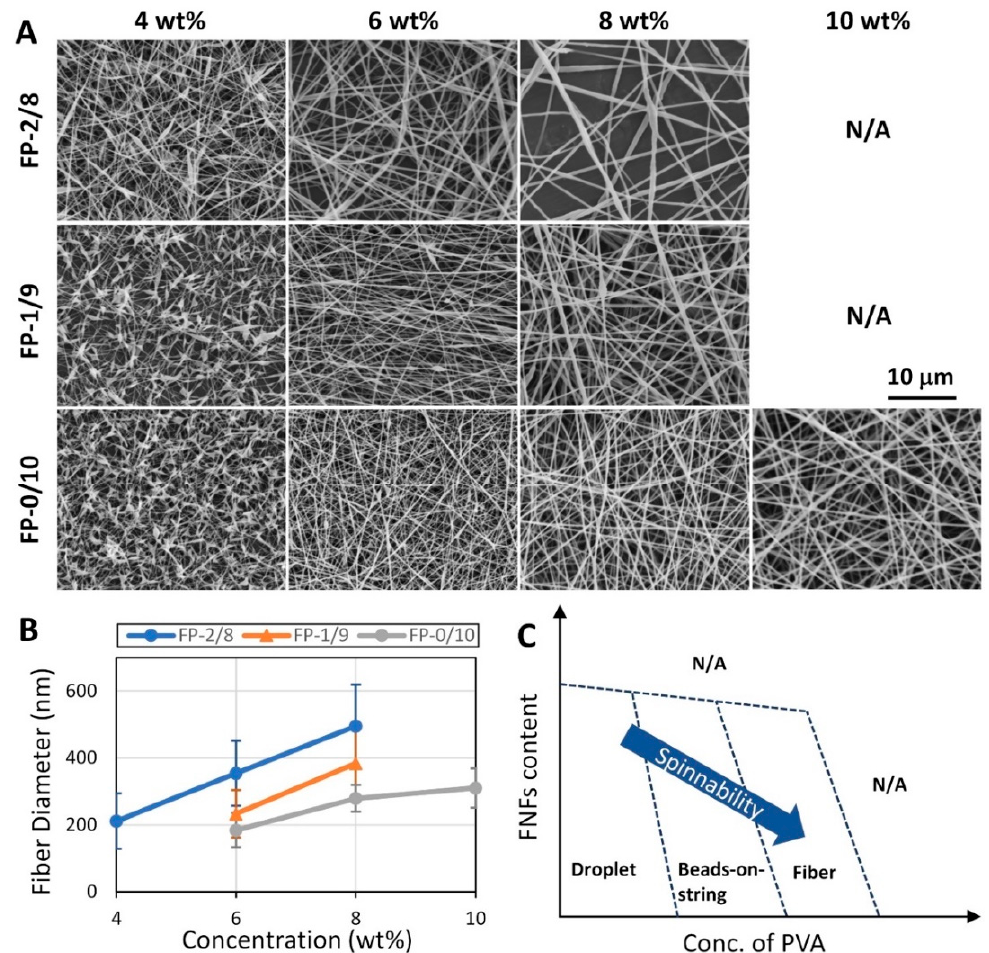
Figure 1. ( A ) Morphologies of FNFs/PVA nanofibers produced at concentrations of 4, 6, 8, and 10 wt%, and ( B ) the corresponding fiber diameters. ( C ) Phase diagram of the spinnability for the FNFs/PVA spinning dopes.